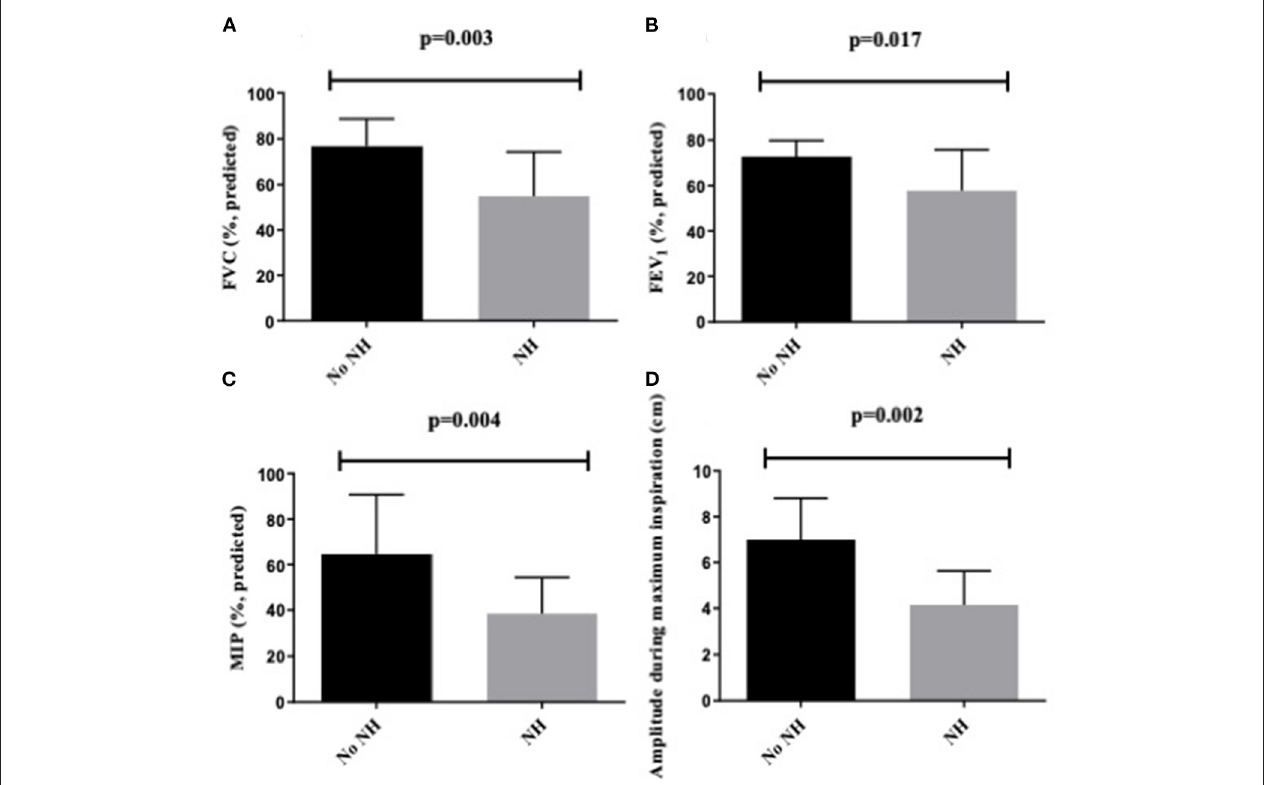
FIGURE 3 | (A) FVC as % predicted, (B) FEV1 as % predicted, (C) MIP as % predicted, (D) diaphragm excursion amplitude during maximum inspiration in cm in patients with and without NH. NH, nocturnal hypoventilation; FVC, forced vital capacity; FEV1, forced expiratory volume in 1s; MIP, maximum inspiratory pressure.